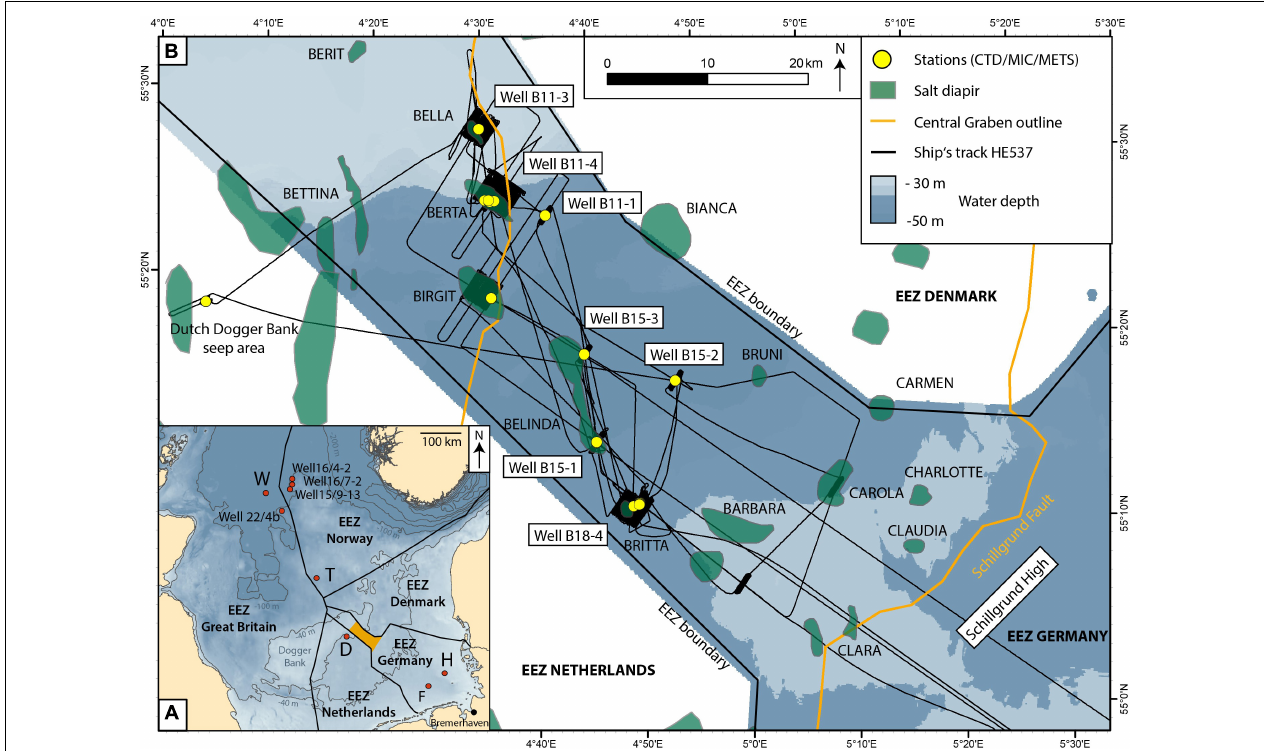
FIGURE 1 | (A) Overview of the study area in the German Exclusive Economic Zone [EEZ, Flanders Marine and Institute (2019)] of the North Sea (orange area). Known seep sites are marked as red dots. D: Dutch Dogger Bank seep area (Schroot et al., 2005), F: Figge-Maar (Thatje et al., 1999), H: Helgoland Reef pockmark field (Krämer et al., 2017), T: Tommeliten seep area (Hovland, 1993), and W: Witch Ground Basin (Judd et al., 1994). Bathymetry downloaded from www.gebco.net. (B) Overview of the study area in the “Entenschnabel,” the northwestern part of the German EEZ. Major structural features depicted from Arfai et al. (2014) are the Central Graben (outlined in orange) and salt diapirs in the subsurface (green areas). Yellow dots point to sampling and measurement stations during R/V Heincke cruise HE537 conducted at seven abandoned well sites, a reference site at salt diapir Birgit, and the Dutch Dogger Bank seep area for comparison. Bathymetry downloaded from